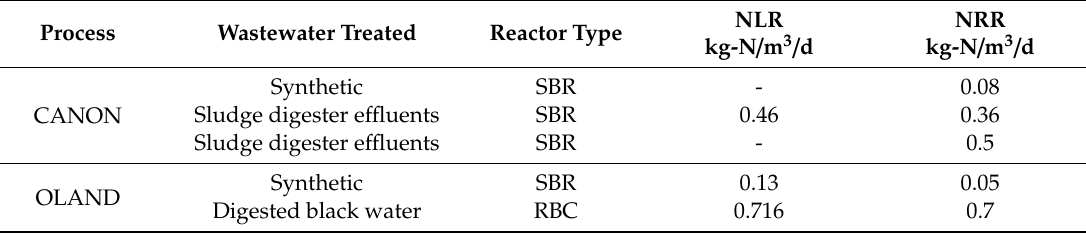
Table 3. Comparison of the denitrification performance of CANON and OLAND